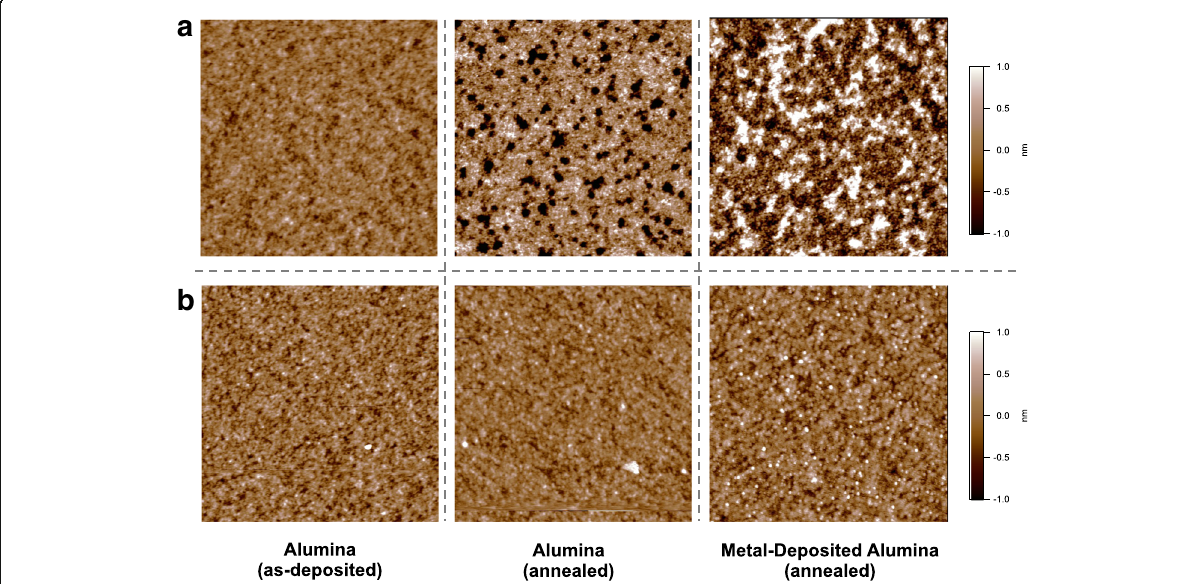
Fig. 2 AFM images of alumina and Fe/Mo/alumina catalyst surface that show morphology change by thermal annealing ( T a =850 °C.) Alumina was deposited by nonreactive sputtering with argon ( a ) and by reactive sputtering with argon and oxygen ( b ). The scanning area of each image is 1×1 μ m